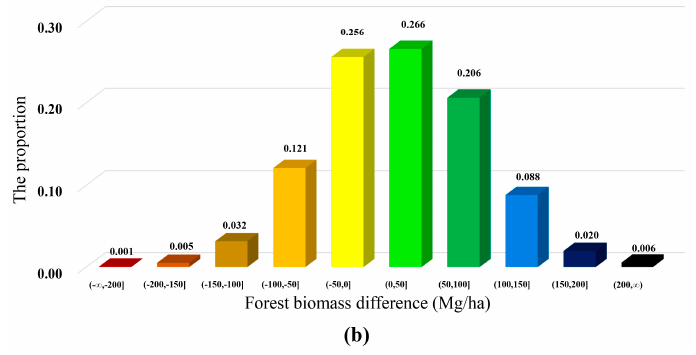
Figure 9. The results of forest biomass difference. ( a ) The map of biomass difference in Maryland; ( b ) The statistical result of biomass difference.